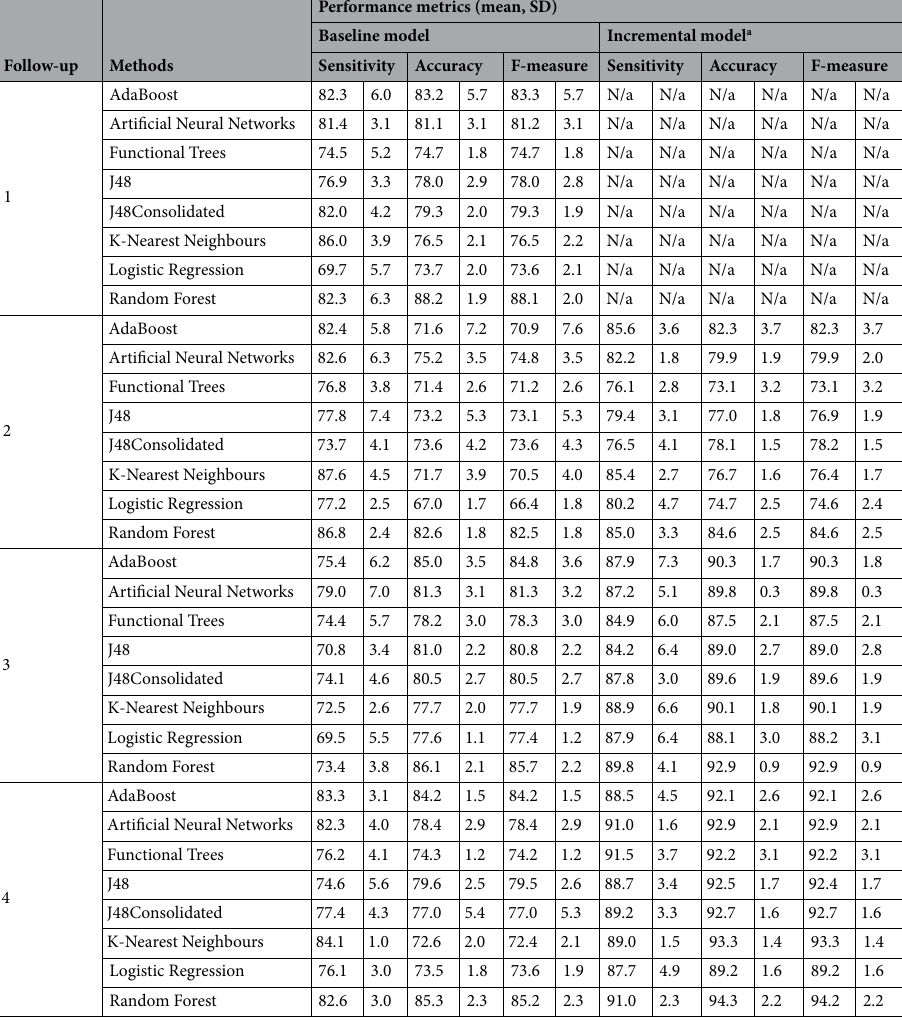
Table 2. Performance results of the classification methods applied to the prediction of attrition in four follow- ups of EPICE-PT cohort. a At follow-up 1, baseline and incremental model are equivalent.